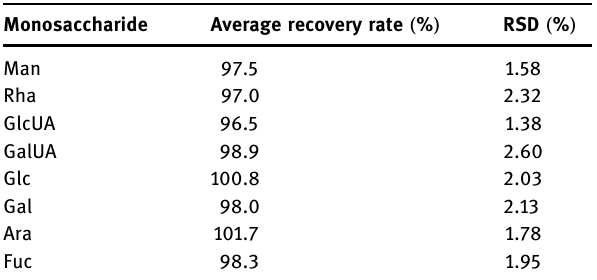
Table 5: Recovery rates of 8 monosaccharides content of RPS